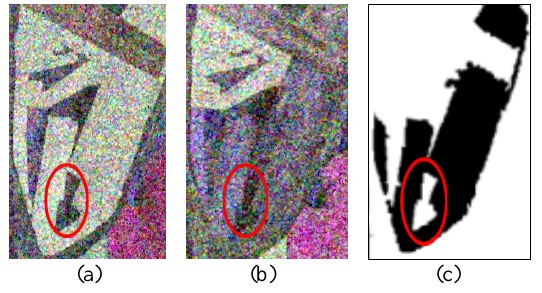
Figure 11. The detail drawings of area 2 and detection result, (a) image 1, (b) image 2, (c) the patch of change detection Fifty patches are selected as samples randomly to assess evaluation of different weights allocation change